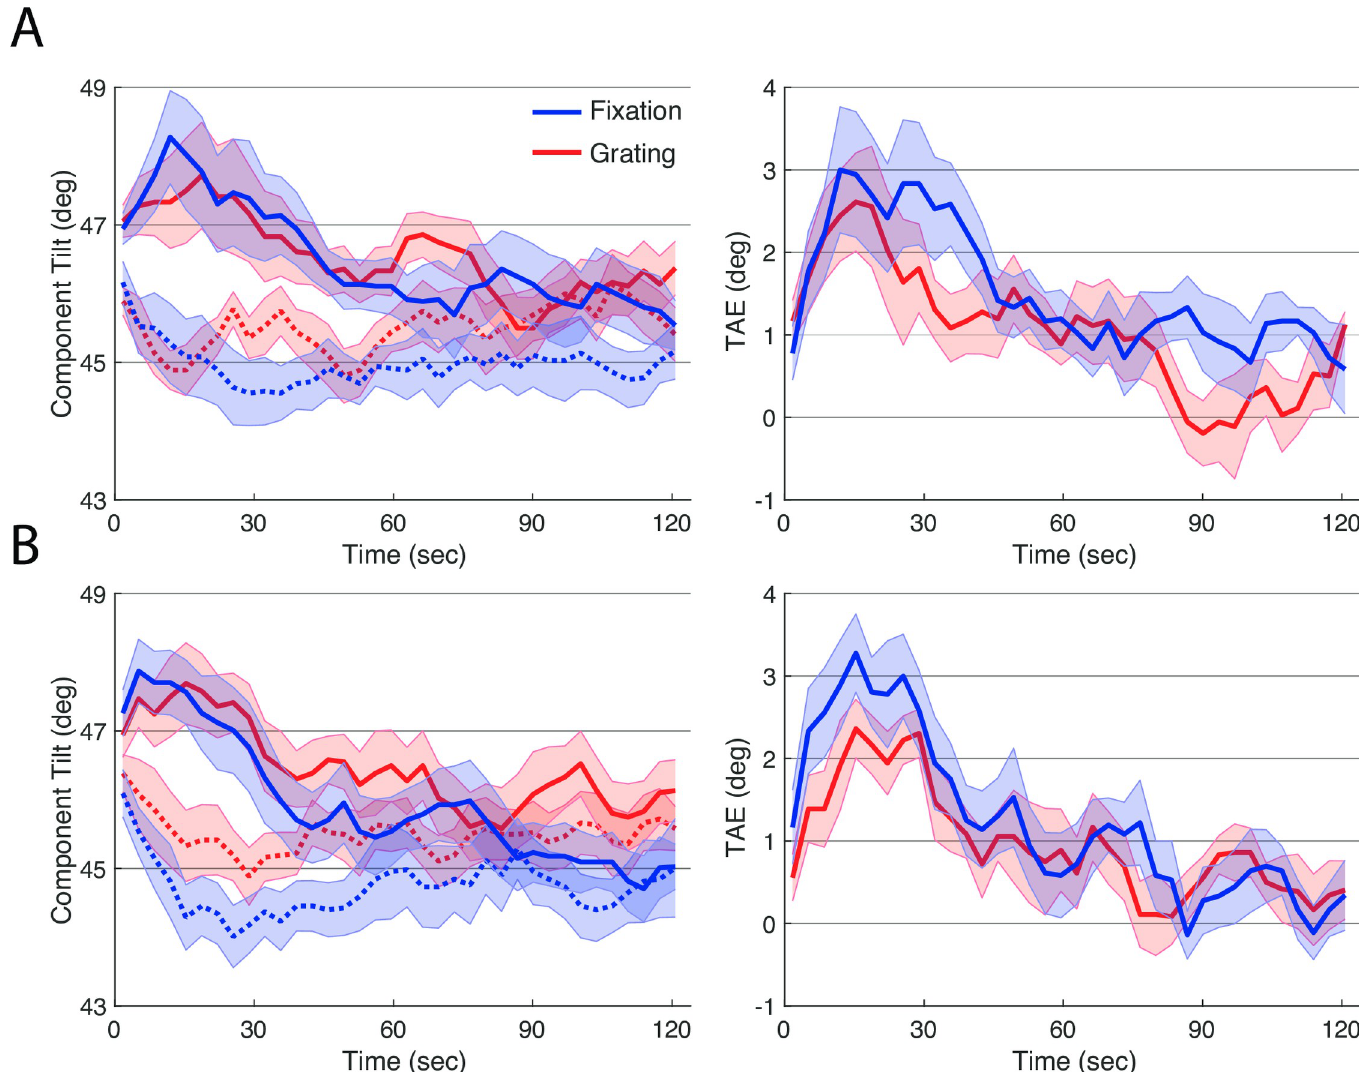
Fig 5. Results of experiment 1 by session. The left and right panels show raw results and effects with baseline subtracted, as in Fig 5. Panel A shows results for the first session, and panel B for the second session. Plotting conventions are as in Fig